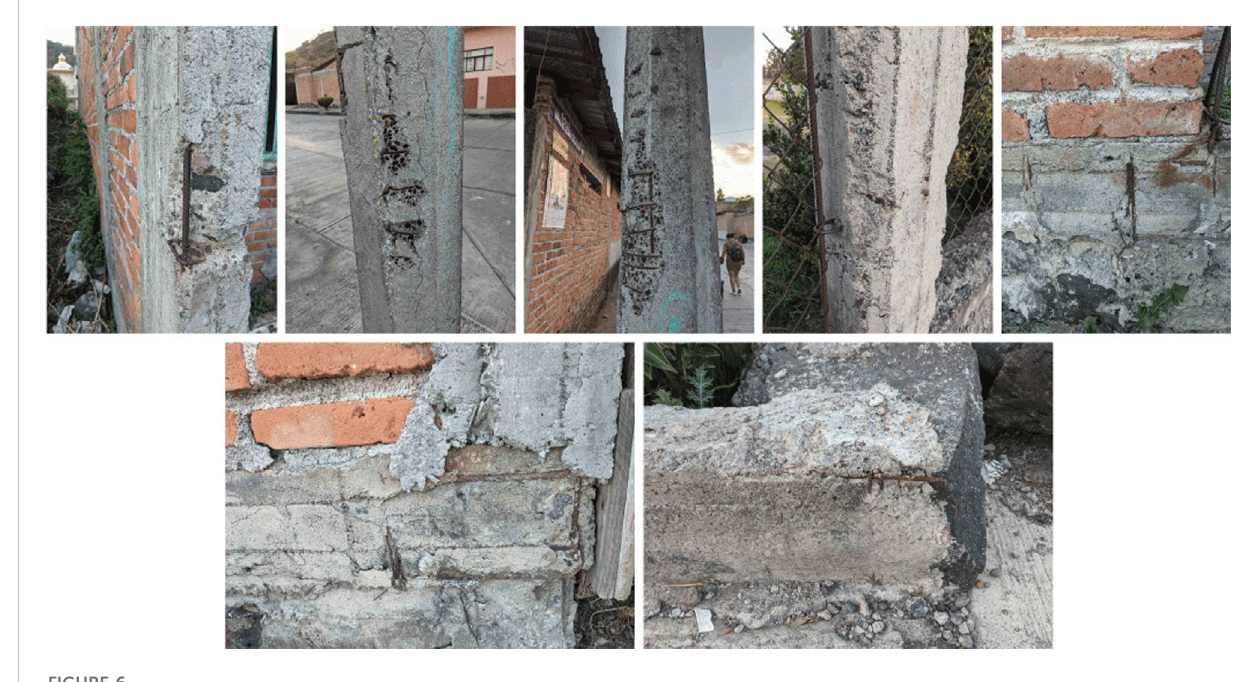
FIGURE 6 Representative images contained in